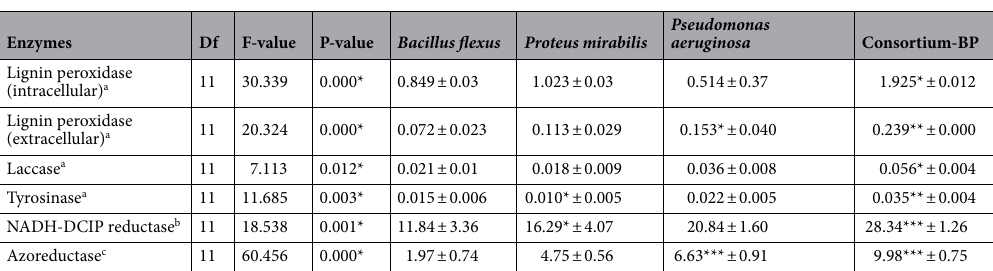
Table 3. Activities of the dye degrading enzymes after 9 h in consortium-BP (complete decolorization), Bacillus flexus TS8, Proteus mirabilis PMS, and Pseudomonas aeruginosa NCH. df: degrees of freedom, Values are mean of three experiments, SEM ( ±), significantly different from Bacillus flexus at *P < 0.05, **P < 0.01, and ***P < 0.001 and by one-way ANOVA with Tukey’s-HSD Comparisons Test. a U min −1 mg protein −1 . b µg of DCIP reduced min −1 mg protein −1 . c µM of methyl red reduced min −1 mg protein −1 .